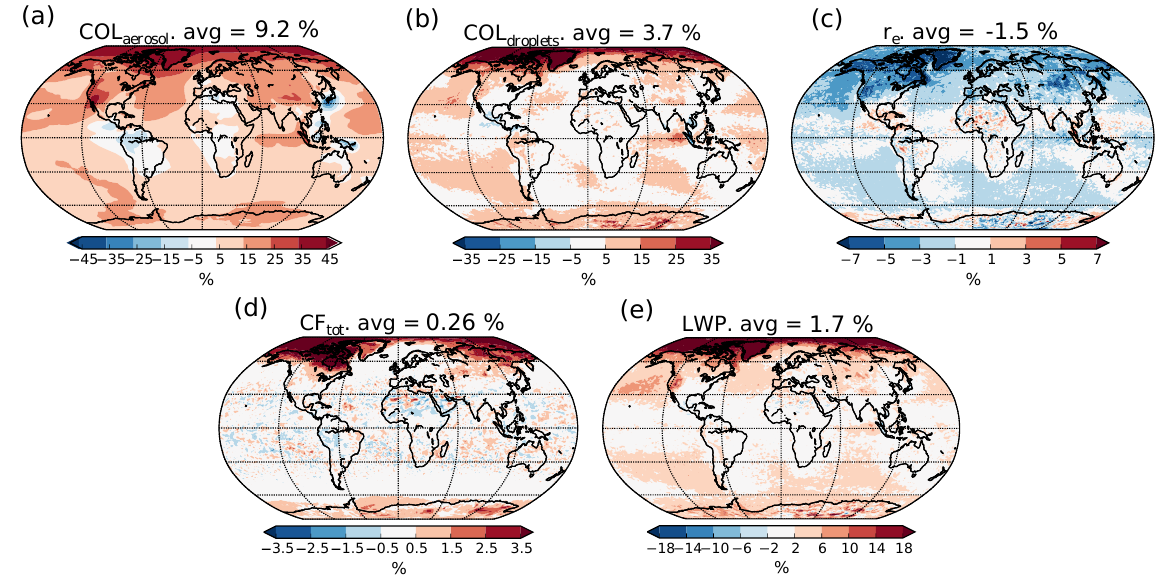
Figure 4. Relative change in aerosol and cloud properties in the PI simulation when switching from PD to PI oxidants. (a) Column number of aerosols, (b) column number of cloud droplets, (c) effective radius of cloud droplets in the cloud top layer, (d) total cloud fraction and (e) total grid box averaged liquid water